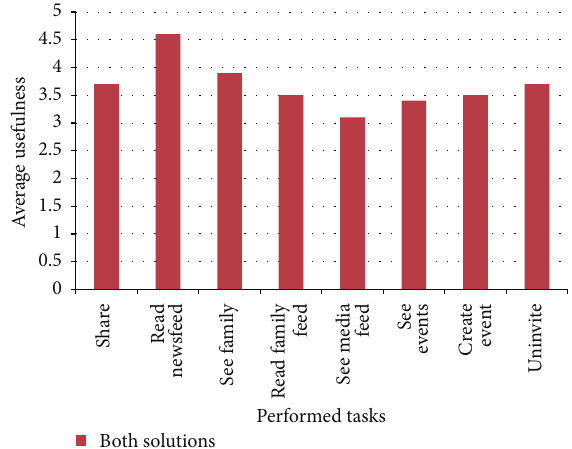
Figure 3: The graph of participants’ perceived usefulness regarding the user studies’